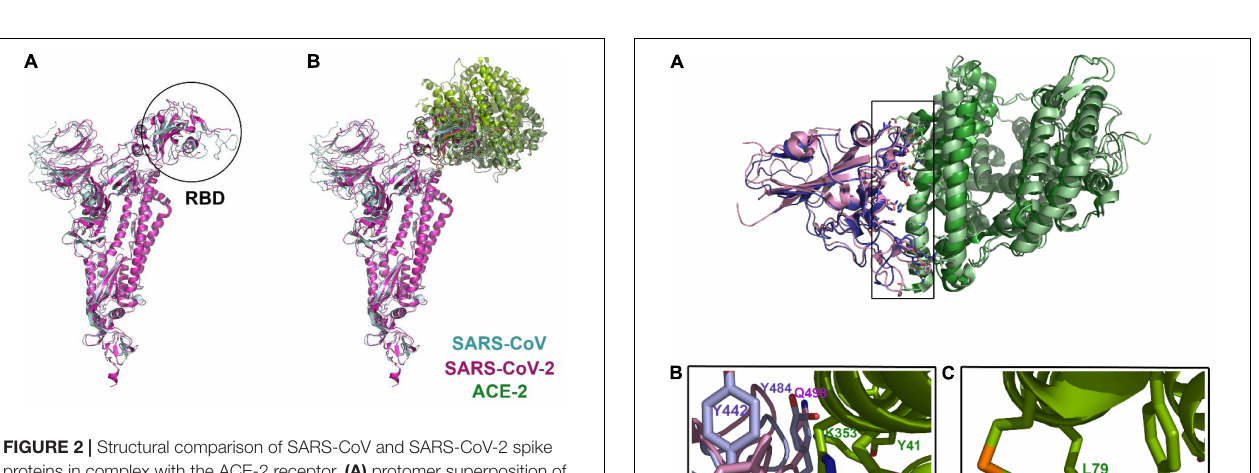
high affinity (K d = 15 nM) reported for the binding between